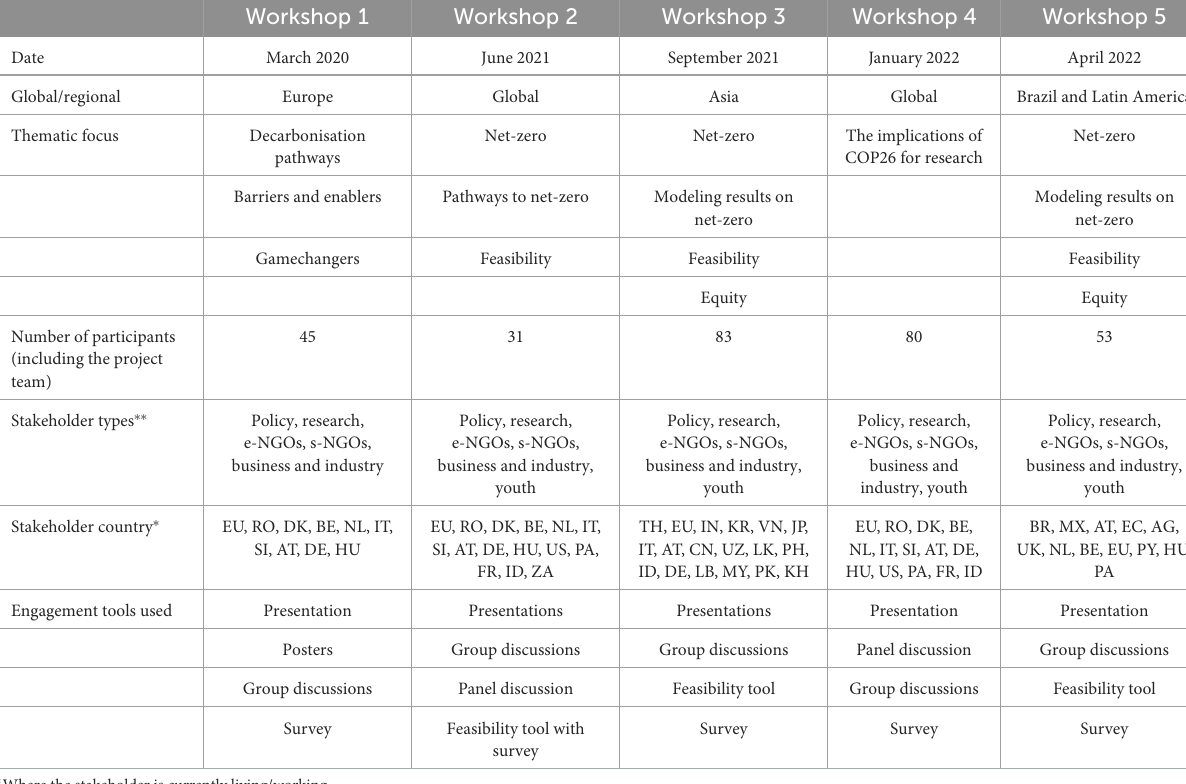
TABLE 1 Online workshops with